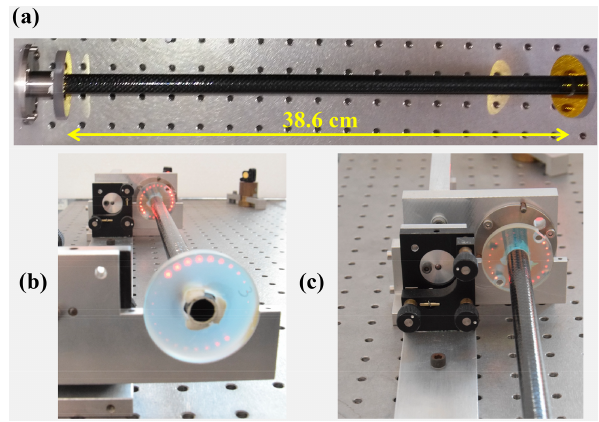
Figure 3. Home-made multipass cell in the open-cell configura- tion (a) . Photo (b) shows the whole cell with the alignment laser beams on the mirrors; photo (c) is a detail of the entrance/exit mir-